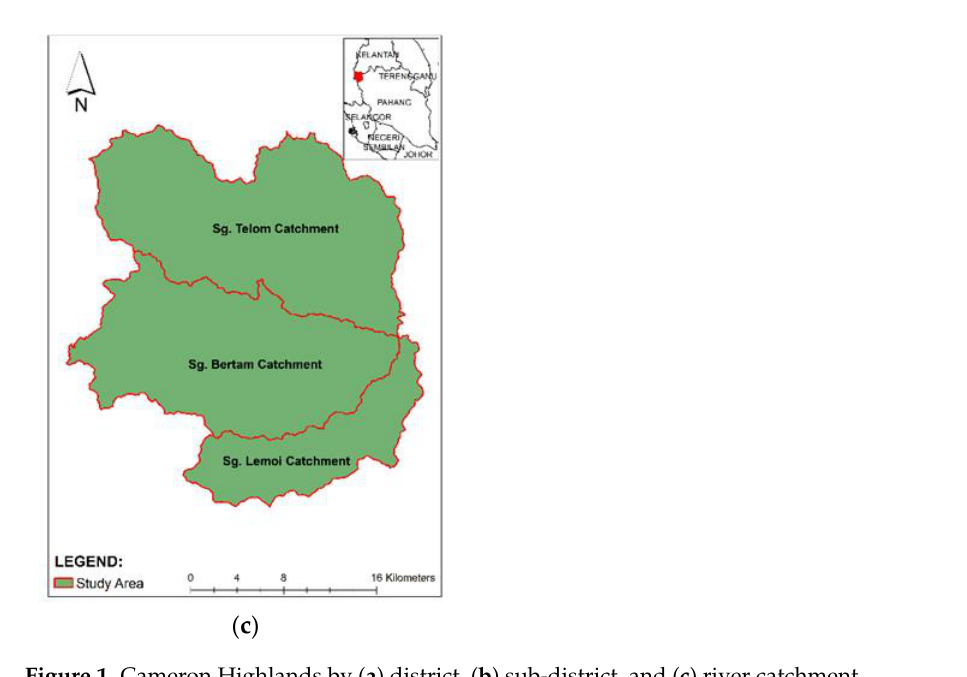
Figure 1. Cameron Highlands by ( a ) district, ( b ) sub-district, and ( c ) river catchment.